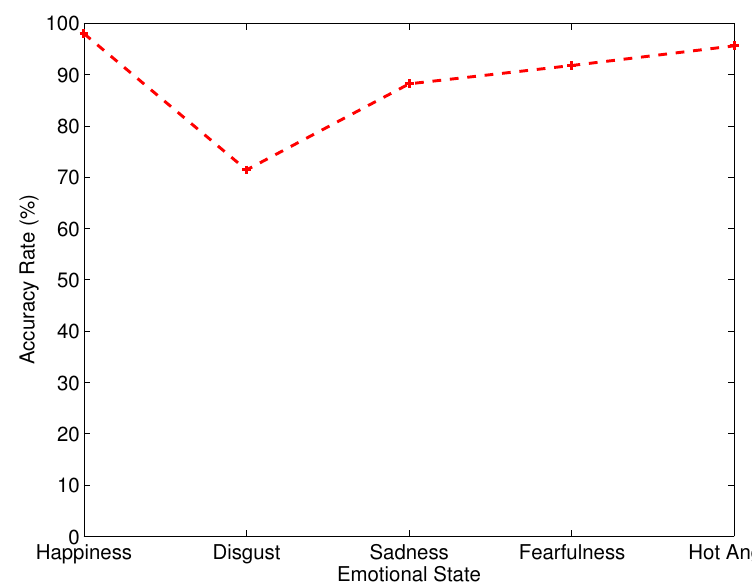
Figure 6. Accuracy rate of the overal